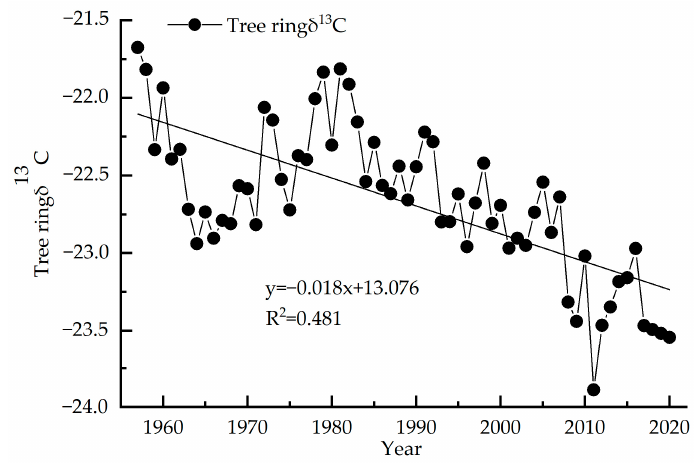
Figure 4. Tree ring δ 13 C of Picea meyeri chronologies on Luya mountain.